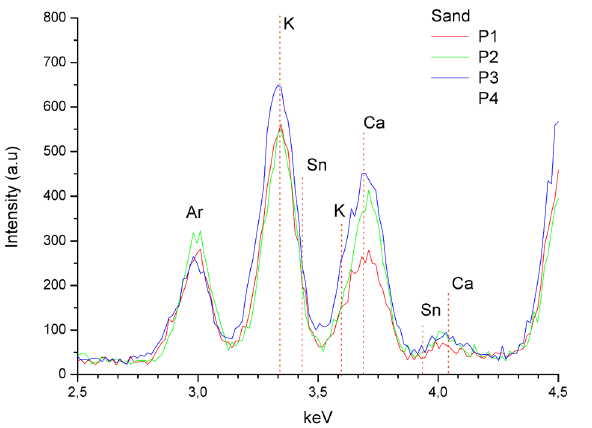
Figure 3. Zoom of XRF spectrum in the energy region of Sn L Argon peak is related to atmosphere.